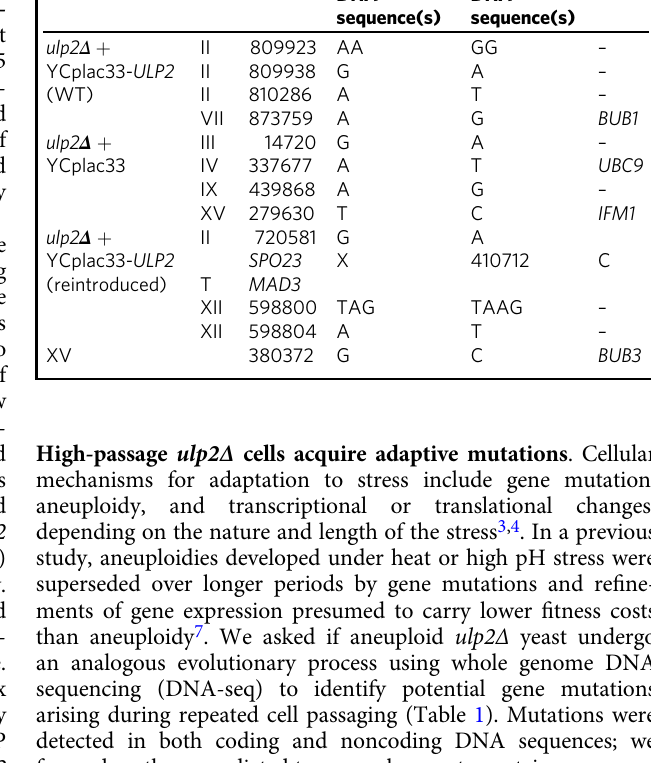
Fig. 4 Identi fi cation of genes on ChrXII suppressing ulp2 Δ aneuploidy. a Strategy used to identify speci fi c regions of ChrXII that suppress ulp2 Δ aneuploidy. A ulp2 Δ /YCplac33- ULP2 strain (MHY1379) was transformed with the indicated pGP564 ( LEU2 )-based ChrXII library plasmids. Cells were struck on